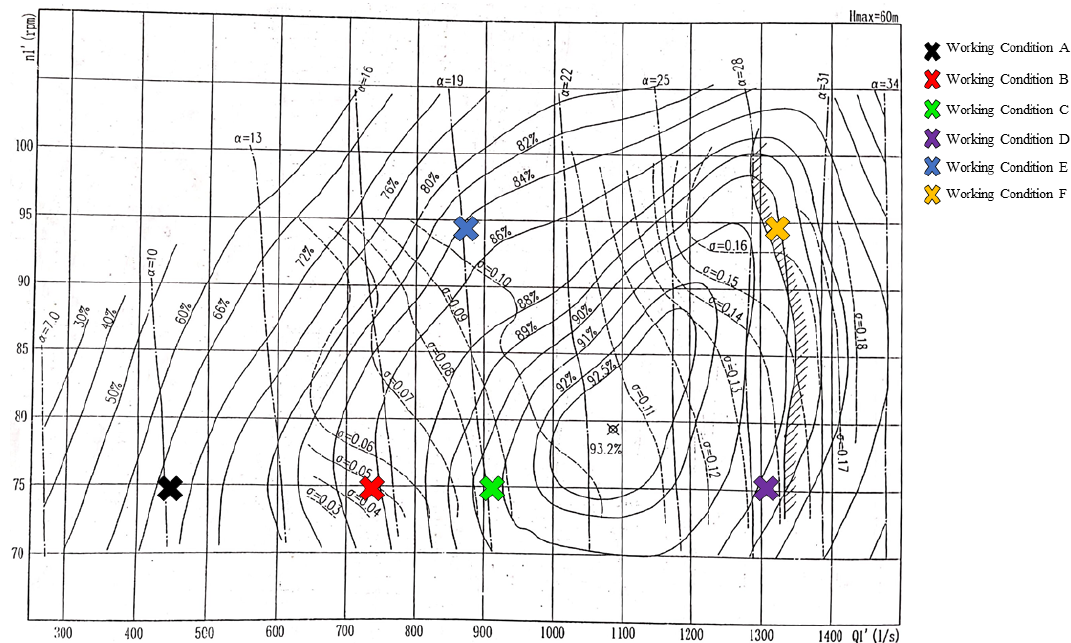
Figure 2. The Francis turbine mesh.